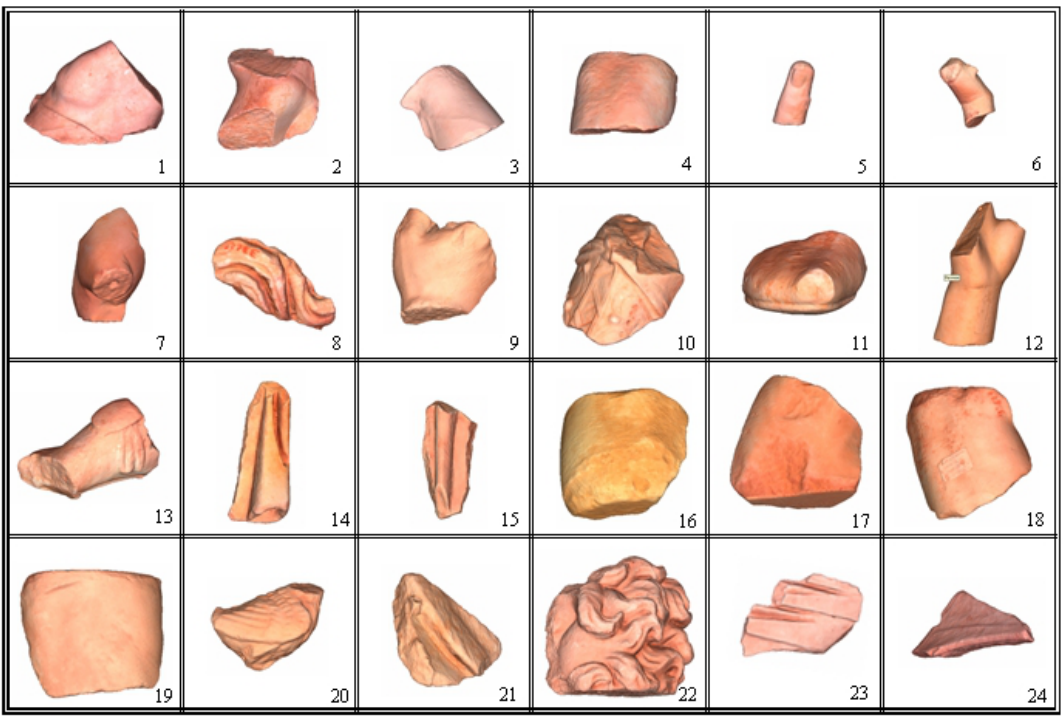
Figure 11. Final models for the small